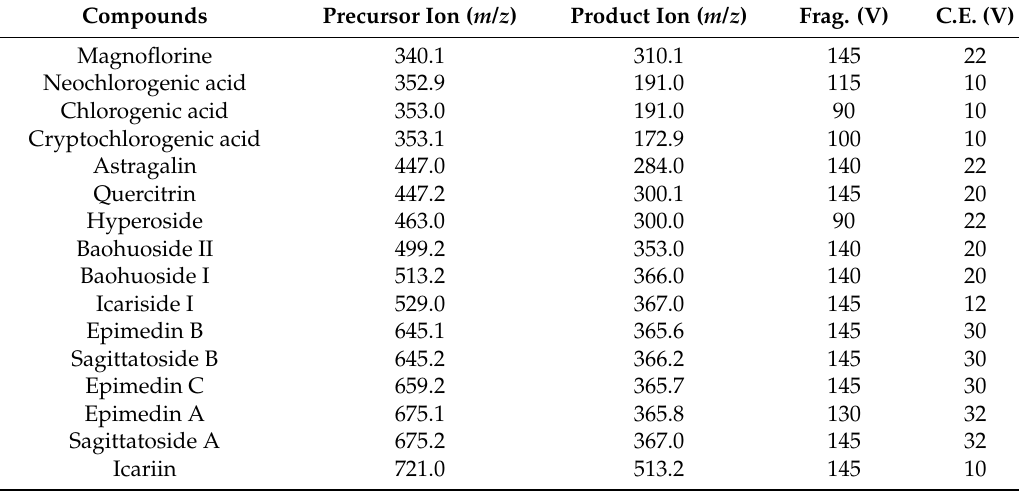
Table 6. Mass spectra properties of 16